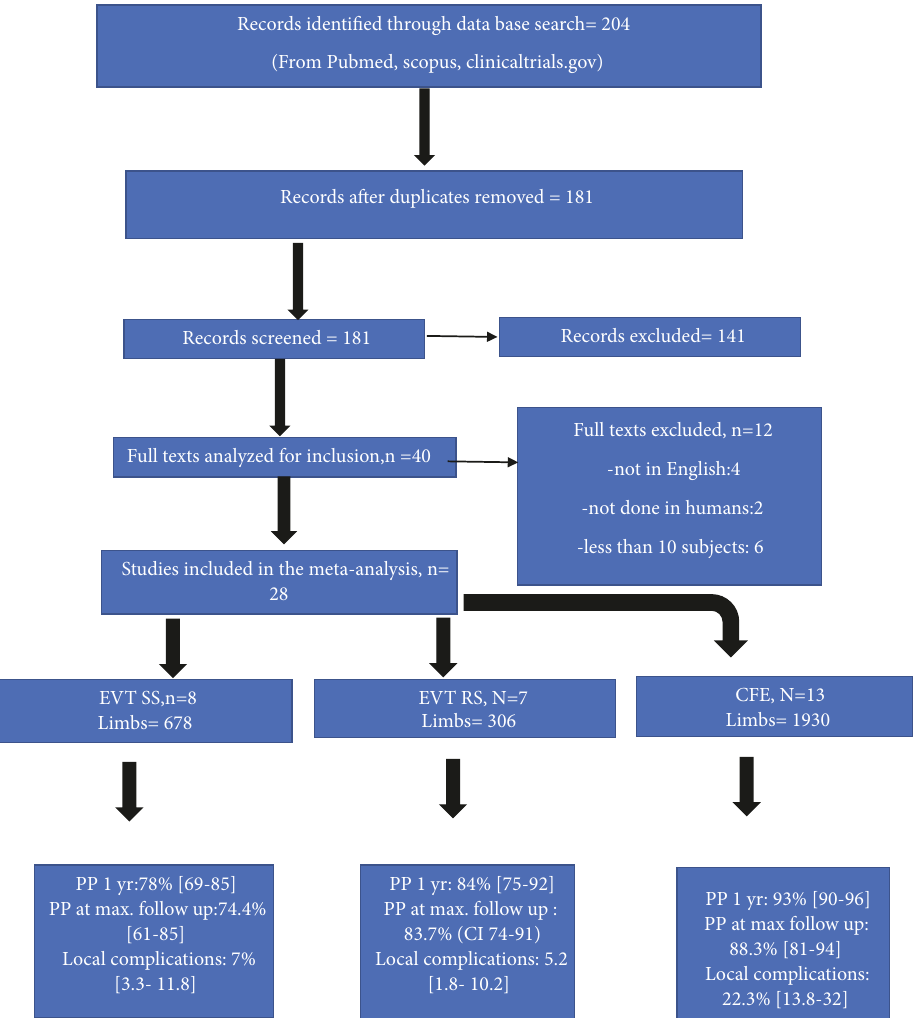
Figure 1: Flowsheet summarizing the selection of studies and main